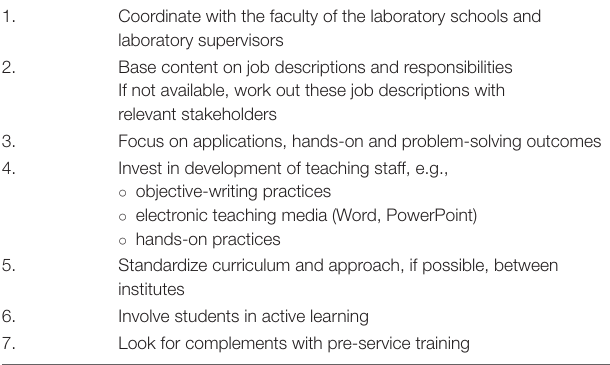
TABLE 5 | Recommendations for designing and implementing a pre-service curriculum for clinical bacteriology laboratory